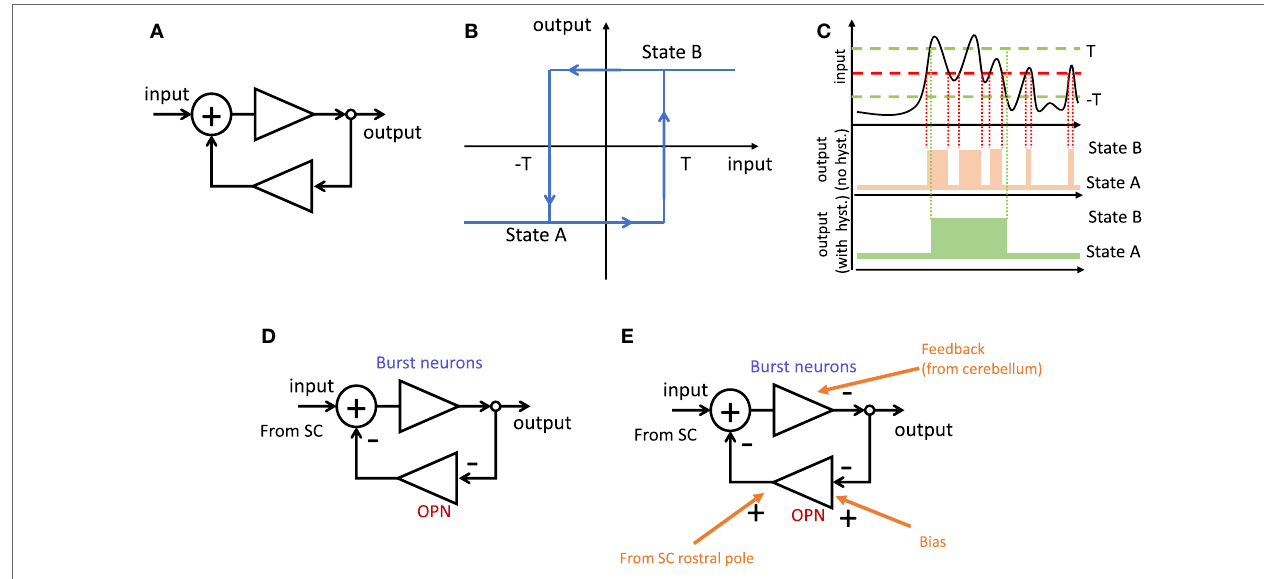
FigUre 2 | Schmitt trigger. (a) Positive feedback loop. (B) Hysteresis function corresponding to (a) . When the system is in state A, the input needs to reach the value T to switch to state B. When in state B, the input needs to reach − T to switch to state A. (c) Effect of hysteresis. Top, example of fluctuating input. Middle, changes of state for a simple threshold (red). Bottom, unwanted switches (in middle panel) can be reduced by having hysteresis with two thresholds (green). (D) The same positive feedback loop as in (a) formed by double inhibition through brain stem neurons. Because burst neurons (BNs) inhibit omnipause neuron (OPN) which in turn inhibit BNs, the result is net positive feedback loop. (e) Further inputs can modulate the behavior of the system. Examples include biasing the threshold or using an additional negative feedback loop to bring the system back to the original state after a switch (that is, ending the